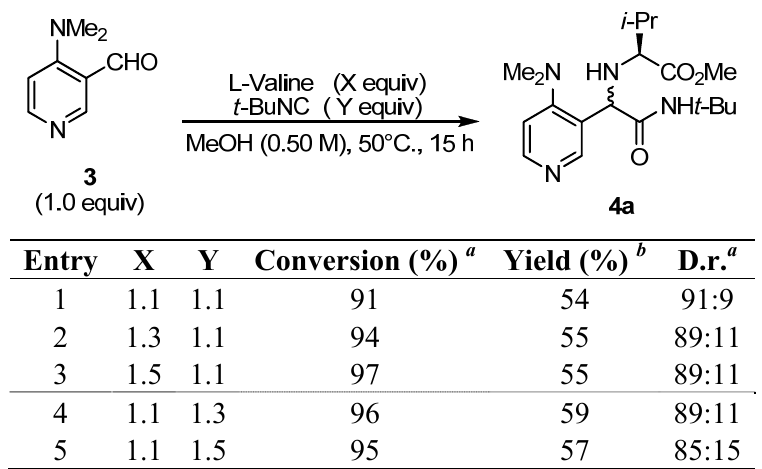
Table 4. Substrate ratios for diastereoselective Ugi reaction of 3 .